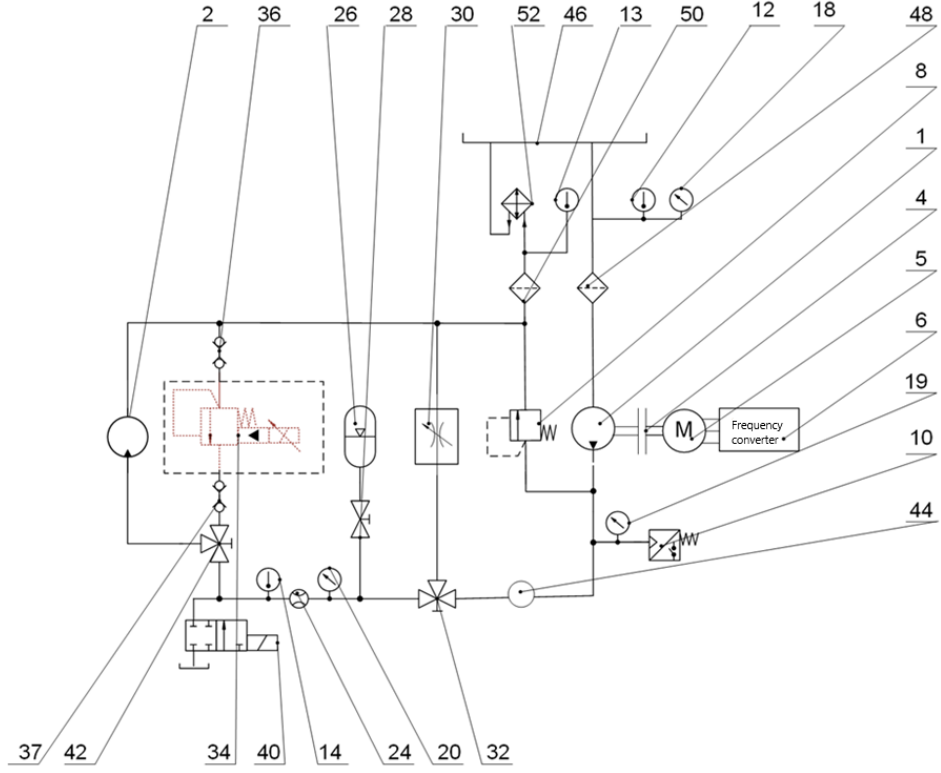
Figure 6. Schematic of the primary circuit of a laboratory test equipment with connection of an electro-hydraulic proportional pressure valve.